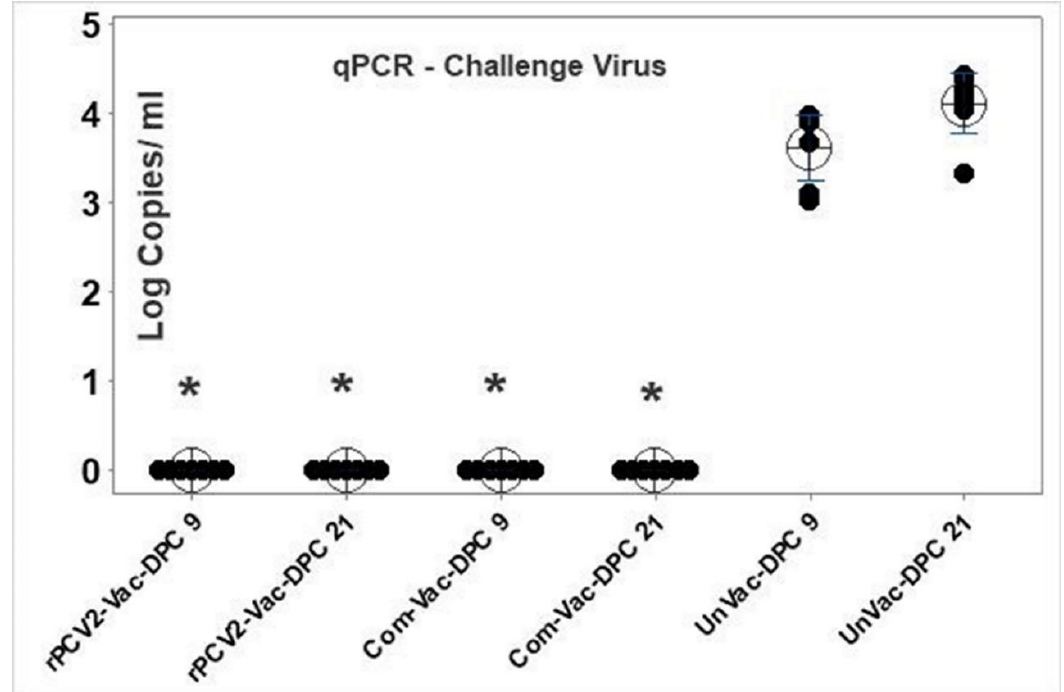
Figure 7. Replication of the challenge virus. Quantification of the heterologous PCV2d challenge virus at 9 and 21 days post challenge by a PCV2d subtype specific qPCR. X axis: experimental groups and time of serum collection, Y axis: log 10 viral copy numbers per mL of serum. Interval bars: 95% confidence interval of the means. * Significantly different from the unvaccinated control group; p ≤ 0.05; Students t test.